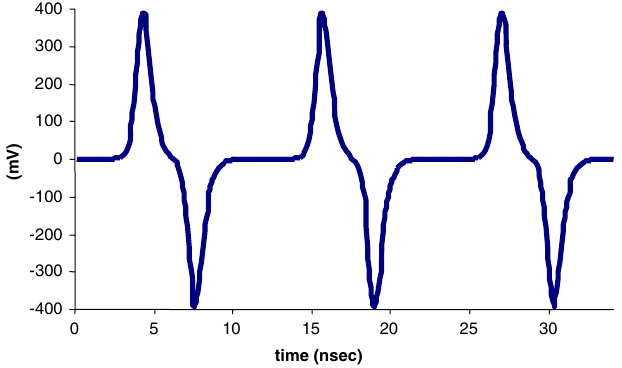
FIG. 7. (Color) The simulated temporal signal from the pickup designed for Spiral2 linac. The aperture is 60 (cid:6) and L ¼ 39 mm . This periodical signal can be decomposed in Fourier series. The first (88.04 MHz) to the fifth coefficients are 127, 133, 41, 45, and 63 mV.